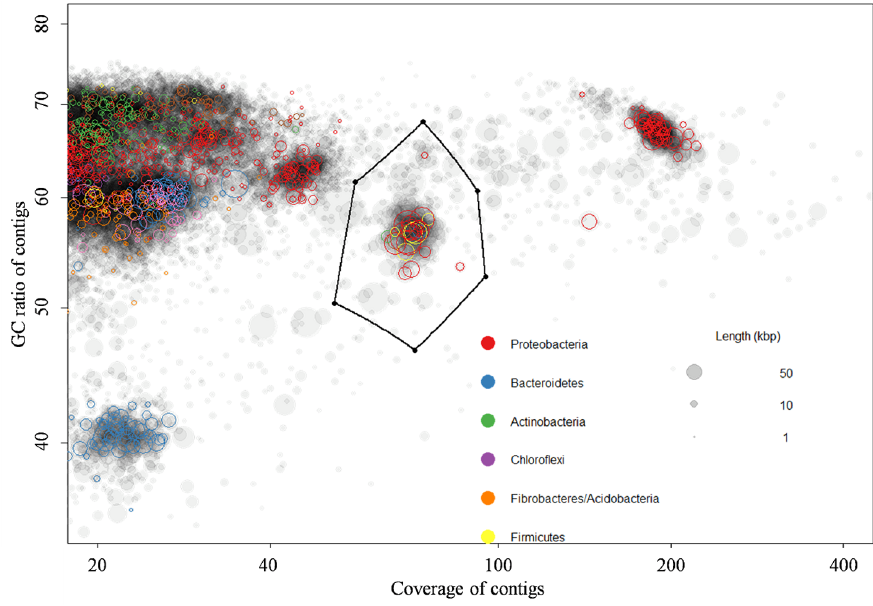
Figure 1. Genome binning of the dominant population with a plot of assembly contigs (based on coverage versus GC ratio). The circles represent the contigs with the size of the square root of their length. Clusters of contigs with similar color present potential genome bins, and contigs cluster with a coverage of approximately 80 (enclosed with black line) were collected for genome binning in this study.